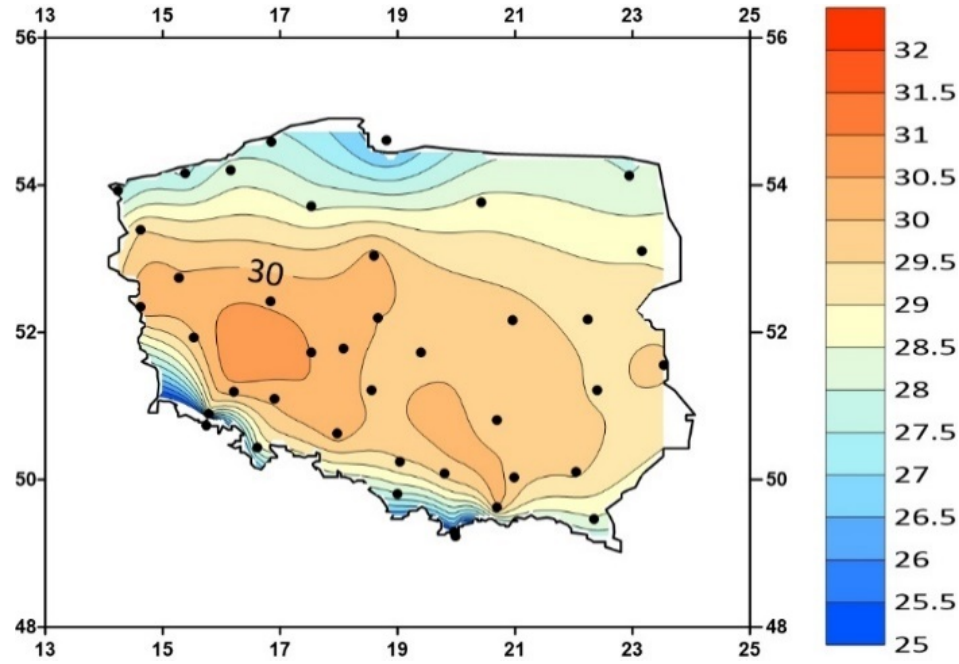
Figure 2. Spatial distribution of 95th percentile of daily maximum temperature on summer days (JJA) in the reference period 1961–1990.